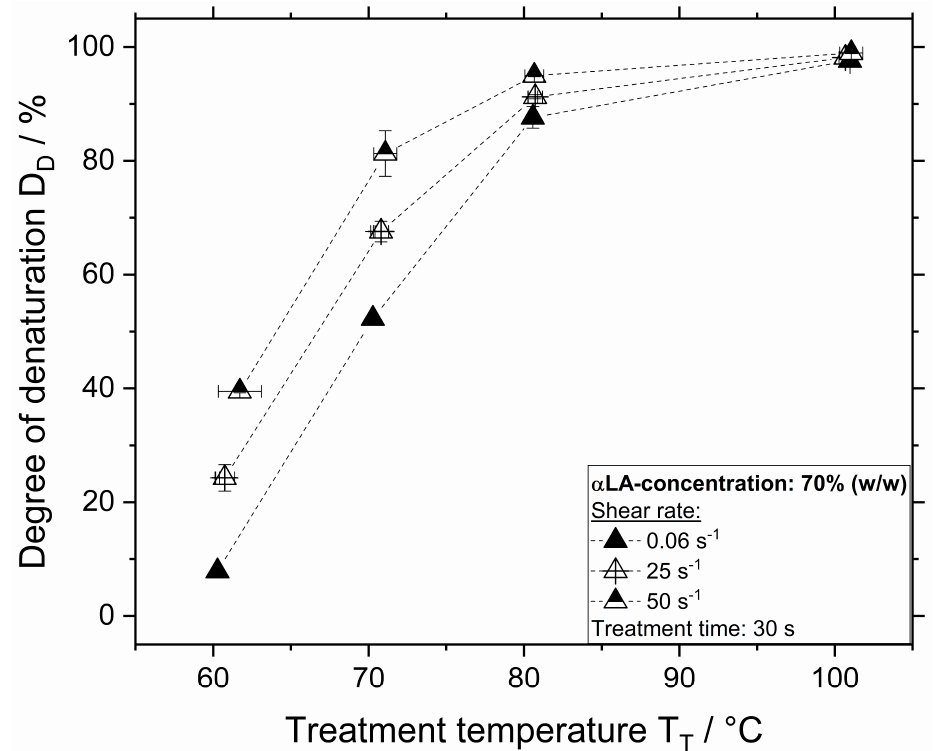
Figure 5. Degree of denaturation as a function of temperature and shear rate for a α LA concentration of 70% ( w / w ) and treatment time of 30